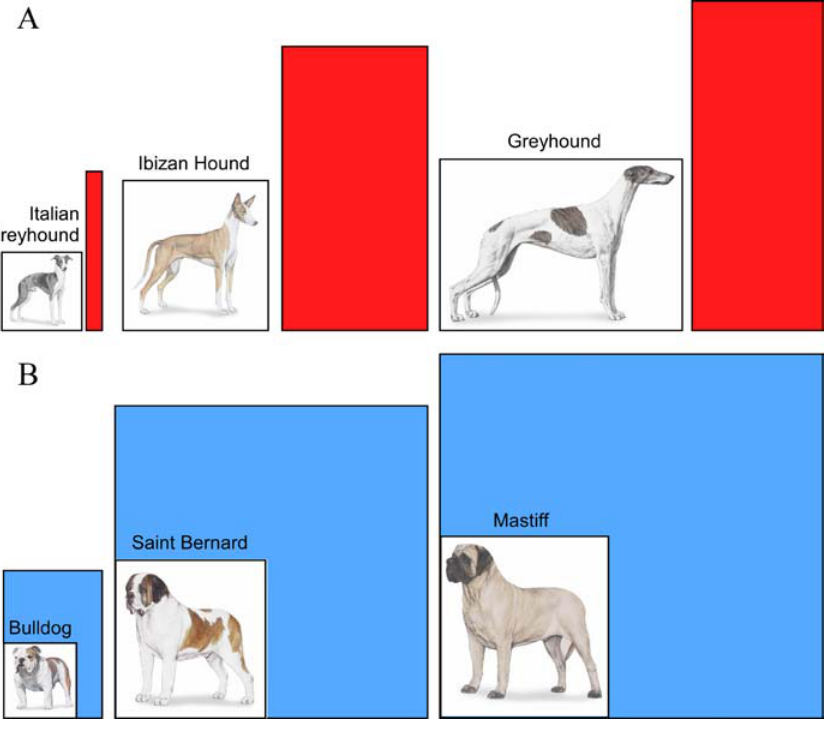
Figure 1. Examples of Breed Morphology Representing a Trade-Off between Speed and Strength Dogs shown in (A)—Italian greyhound, Ibizan hound, and greyhound—have proportionately long, thin legs compared to those in (B)—bulldog, Saint Bernard, and mastiff—which have shorter, thicker bones. The colored box indicates the ratio of height at the shoulder in centimeters to weight of males in